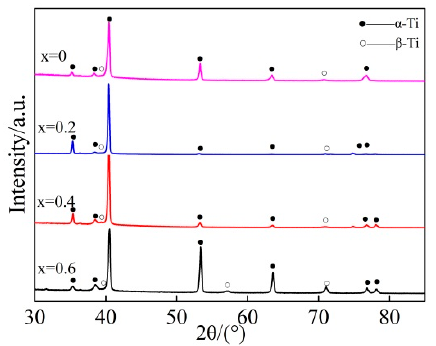
Figure 1. X-ray di ff raction patterns of Ti6Al4V-xEr casting alloys. Figure 1. X-ray diffraction patterns of Ti6Al4V-xEr casting alloys. Figure 1. X-ray diffraction patterns of Ti6Al4V-xEr casting alloys.